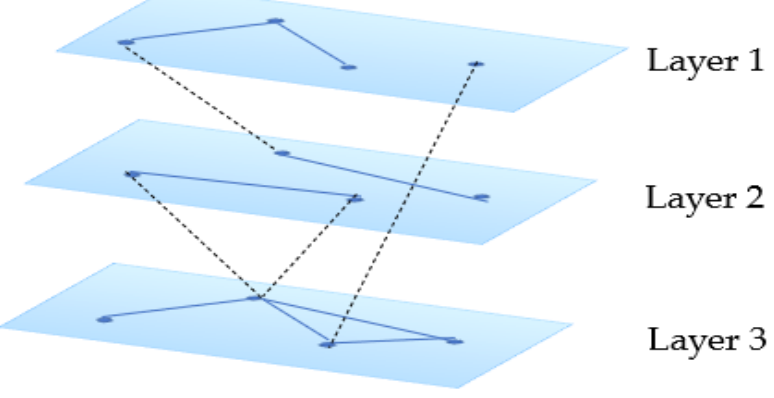
Figure 1. A multiplex example.